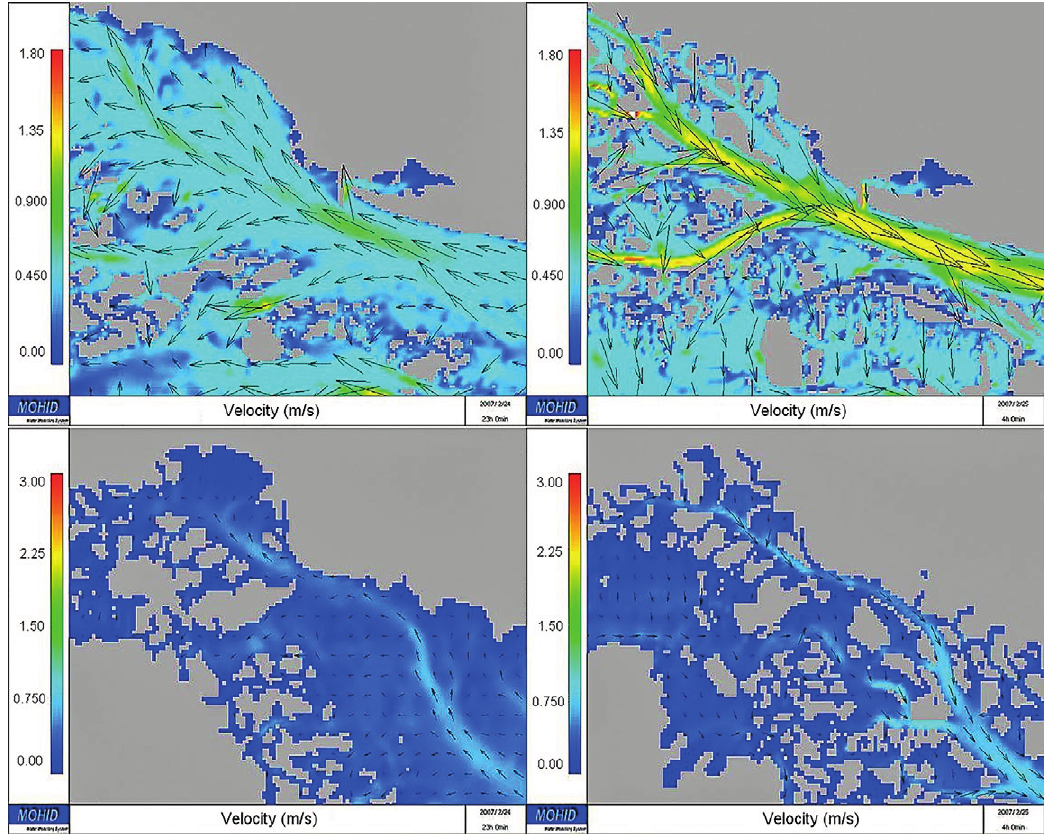
Fig. 8. – Tidal current representation of the middle zone (top) and the inner zone (bottom) of the main channel. To the right the current is observed at rising tide (23 hs on 24-2-2007) and to the left at falling tide (4 hs on